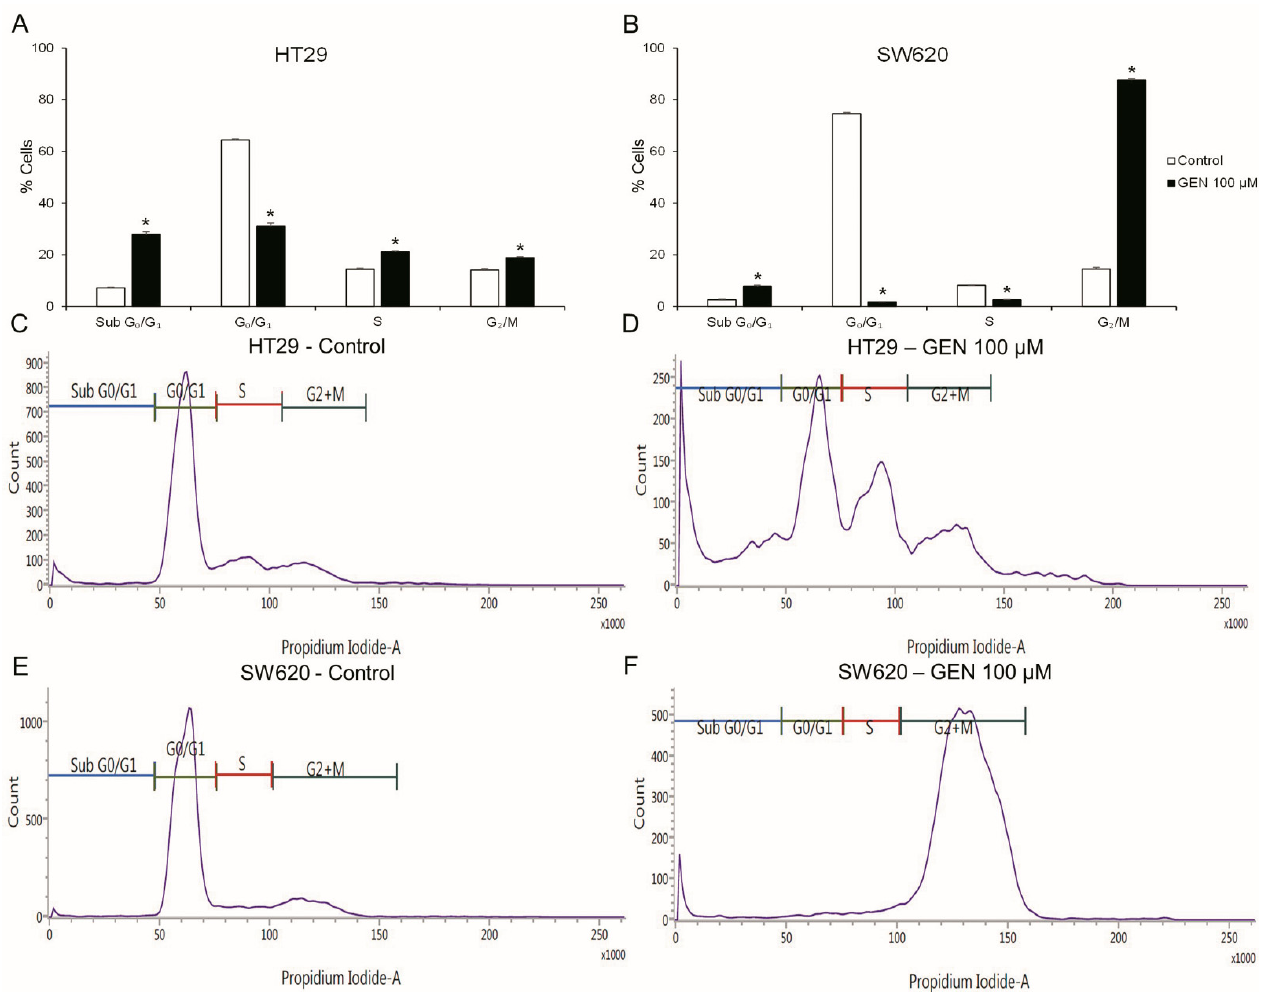
Figure 2. Effects of genistein on cell cycle in ( A ) HT29 cells and ( B ) SW620 cells, determined by flow cytometry. Representative event count and propidium iodide fluorescence in HT29 cells ( C , E ) and SW620 cells ( D , F ). The measurements were made with 0.1% DMSO (control cells, ( C , D )) or genistein 100 μ M ( E , F ) treatment for 48 h. Values are expressed as mean ± SEM. GEN, genistein. * Significant difference between control cells and genistein ‐ treated cells (Student’s t ‐ test; p < 0.05, n = 6).